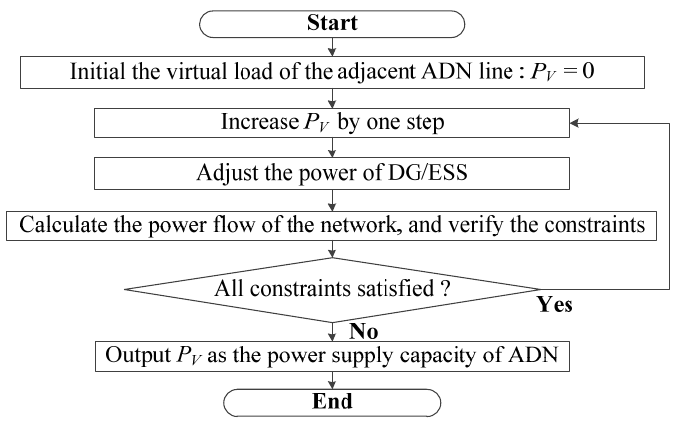
Figure 5. Block diagram of calculating the power supply capacity of an ADN